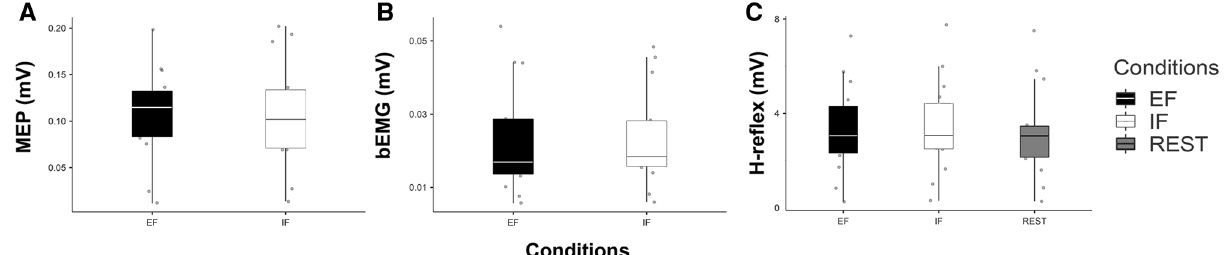
Figure 4. In all graphs, shown are individual values ( n = 14) and boxplots comparing of ( A ) the test single- pulse MEPs (unconditioned) under both attentional strategies (EF and IF), ( B ) background activity of the SOL muscle 100 ms before TMS and/or PNS (bEMG) under both attentional strategies (EF and IF) and ( C ) the test H-reflexes (unconditioned) under both attentional strategies and the REST condition (no contraction and no specific focus of attention). No significant difference was found in all these parameters between conditions (all P > 0.05 In all graphs, black boxplots represent the external (EF), the white ones the internal focus of attention (IF) and the grey ones the REST condition (no contraction and no